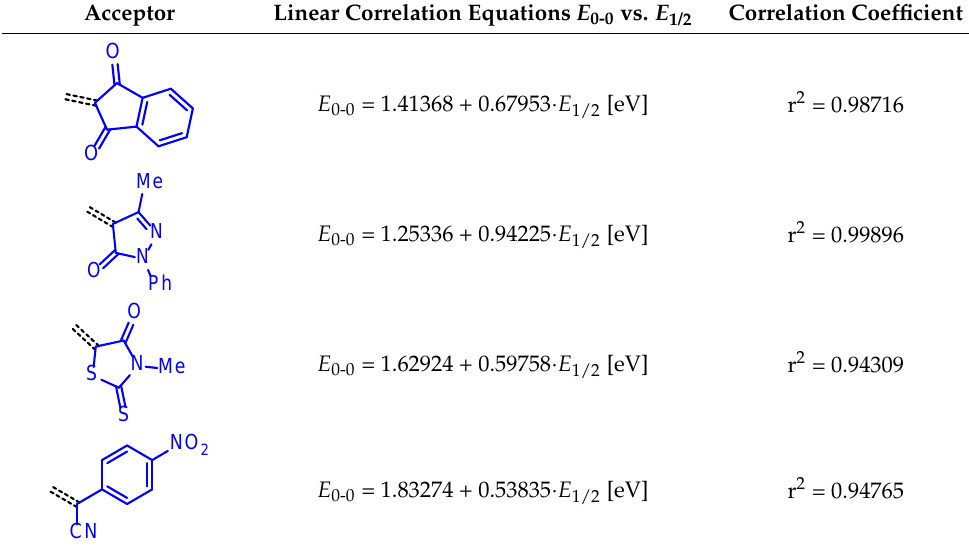
Table 3. Linear correlation analyses of the consanguineous acceptor series.